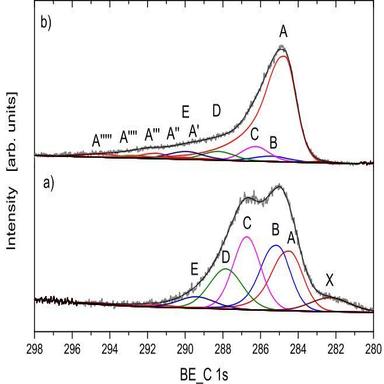
The deconvoluted C 1s spectra for 'as received' GO (a) and commercial graphene (b).